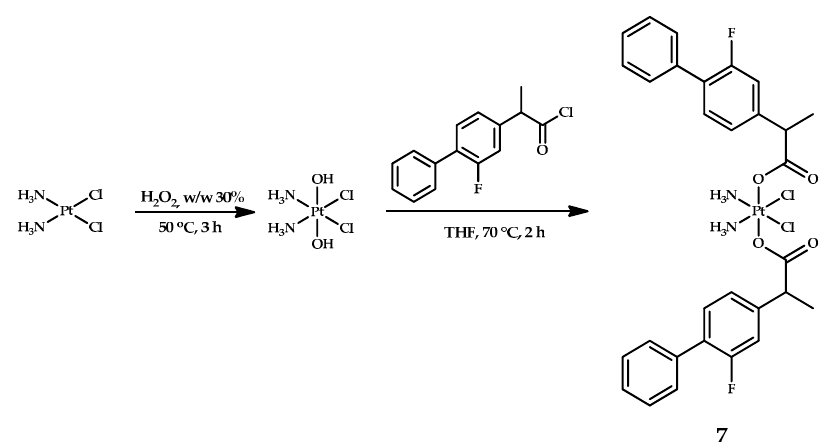
Figure 6. Synthesis of cisplatin-based prodrug 7 with two flurbiprofen moieties as axial ligands. The cytotoxicity of prodrug 7 was evaluated by MTT assay (Table 7). The IC 50 values of